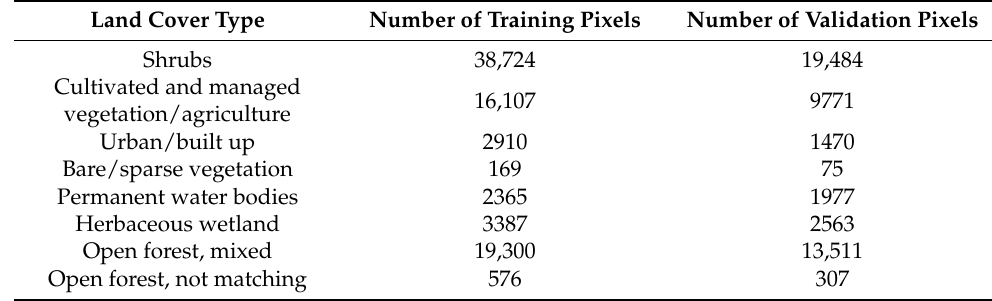
Table 3. The average number of training and validation points for each LULC